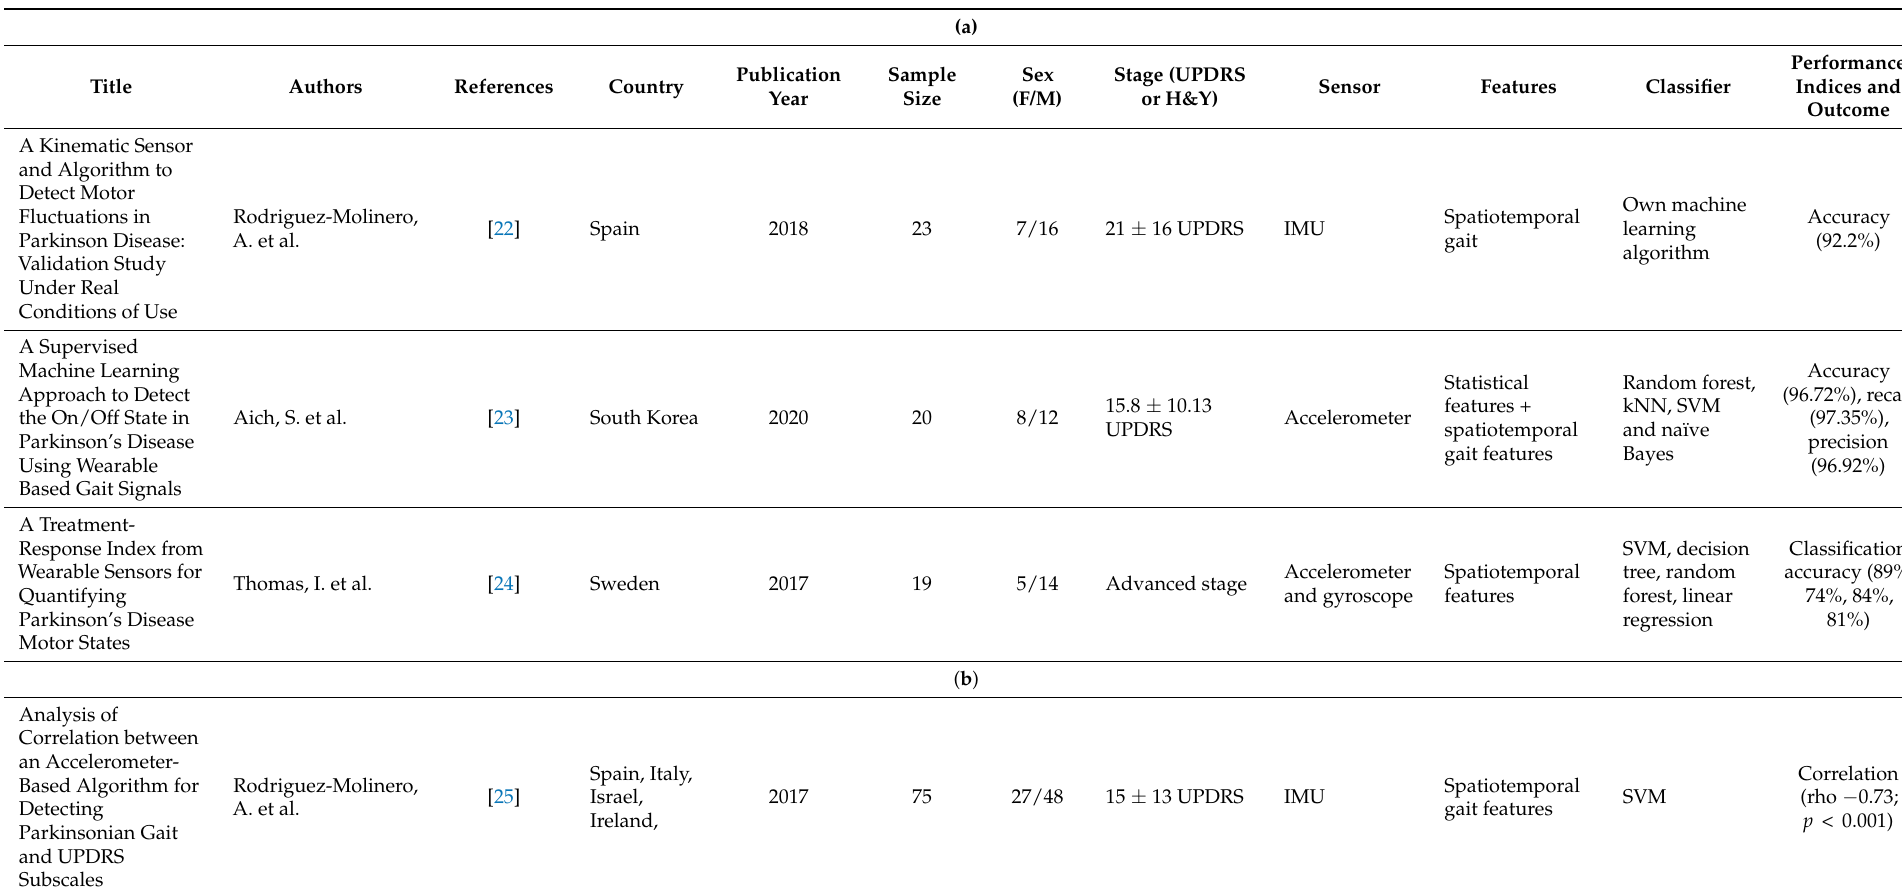
Table 2. ( a ) Characteristics of included studies (I). Acronyms: IMU—inertial movement unit; SVM—support vector machines; kNN—k-nearest nearest neighbor; CNN—convolutional neural networks; UPDRS—unified Parkinson’s disease rating scale; ANN—artificial neural network; H and Y—Hoehn–Yahr; F—female, M—male. ( b ) Characteristics of included studies (II). ( c ) Characteristics of included studies